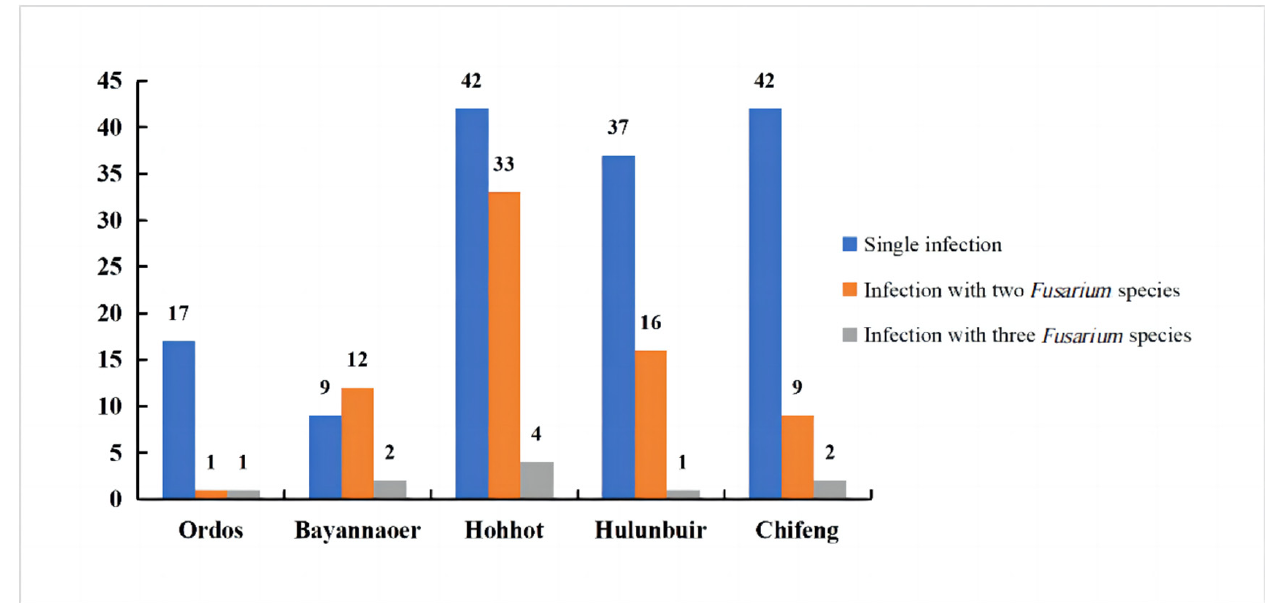
Figure 3. Fusarium infection of alfalfa in different regions of Inner Mongolia, China. The blue column indicates that only one Fusarium species was isolated from alfalfa samples, the orange column indicates that two Fusarium species were isolated from alfalfa samples, and the gray column indicates that three Fusarium species were isolated from alfalfa samples.